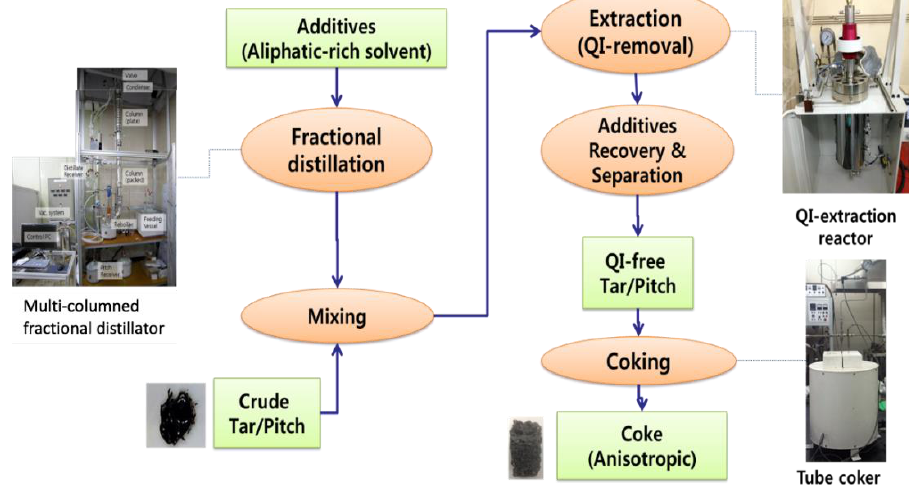
Figure 1. Experimental process flow.